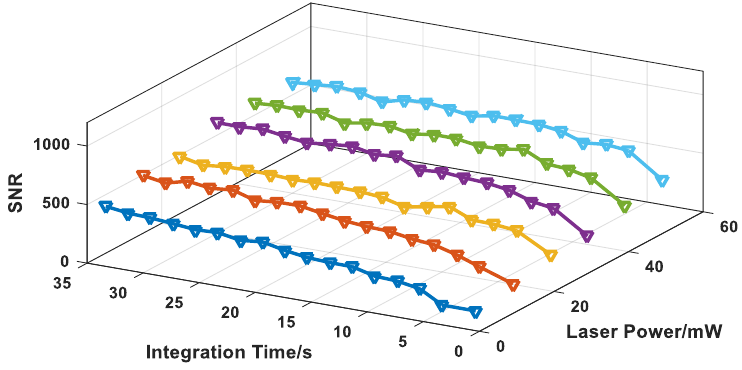
Figure 8. Sulfur SNR curves.